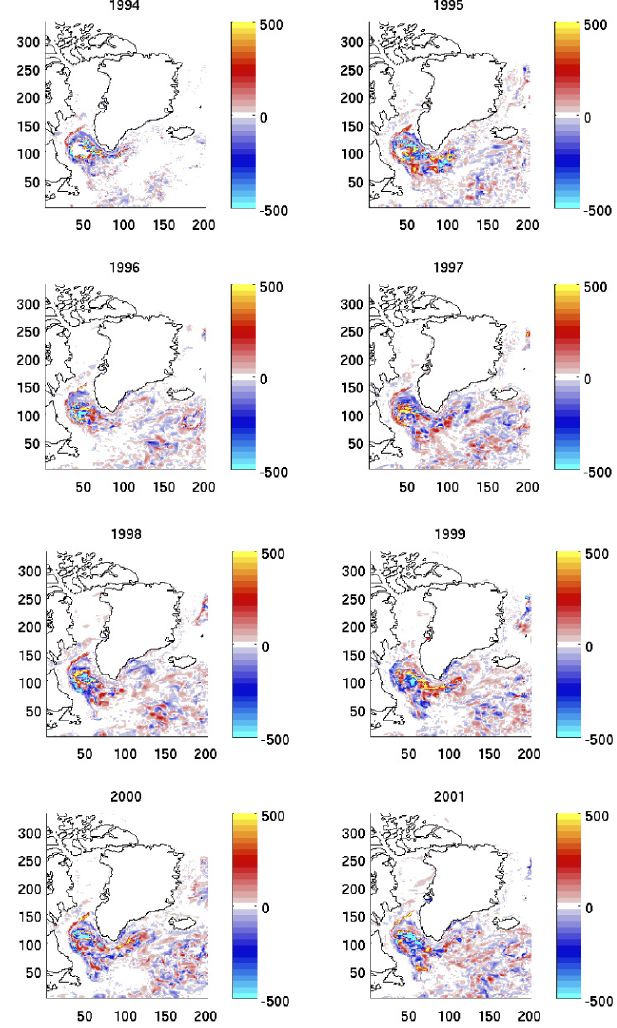
Fig. 11. March mixed layer depth anomalies (m) for the period